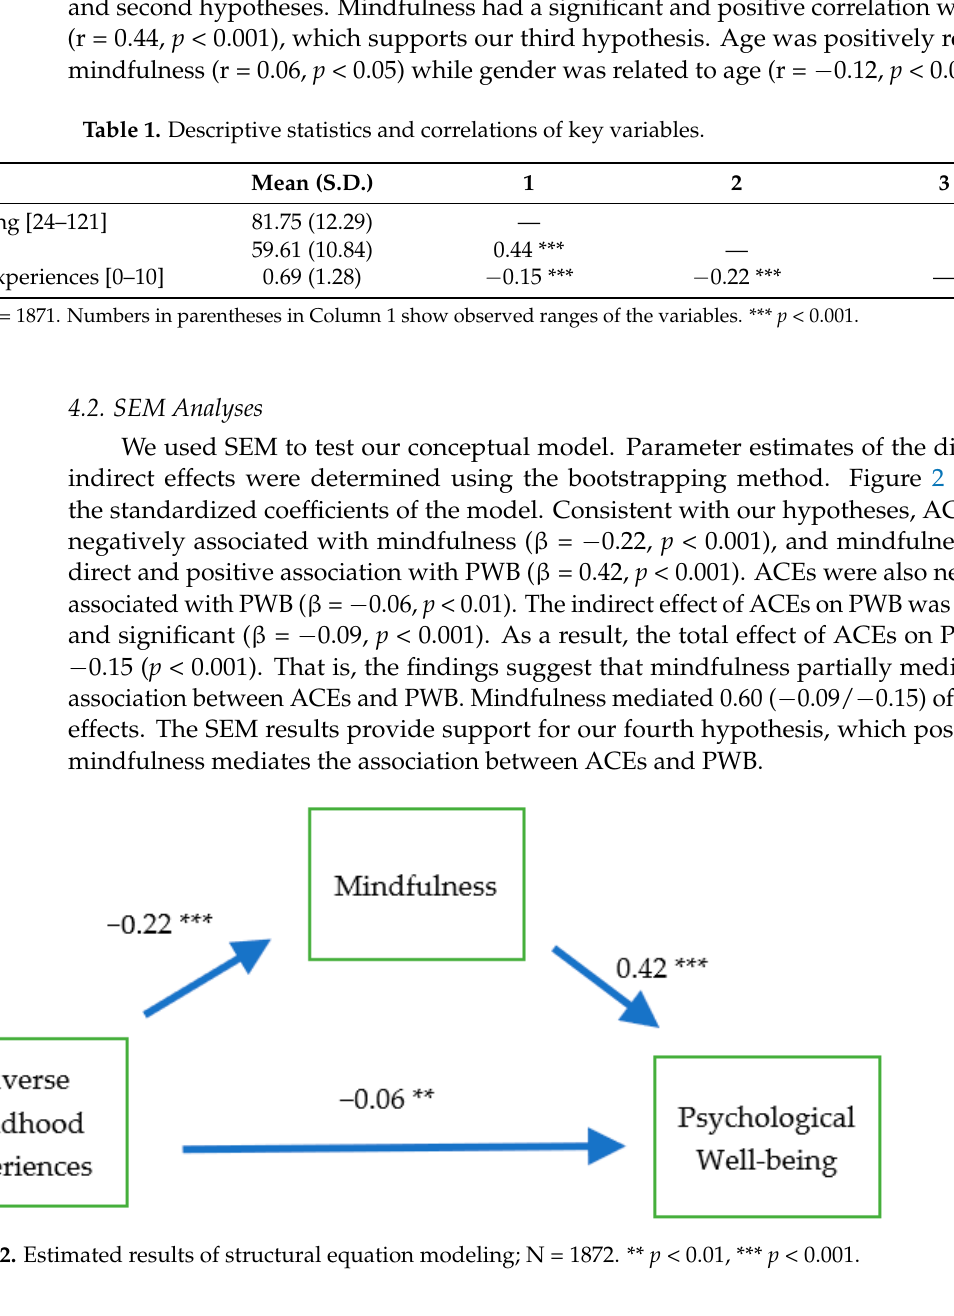
Figure 2. Estimated results of structural equation modeling; N = 1,872. ** p < 0.01, *** p <